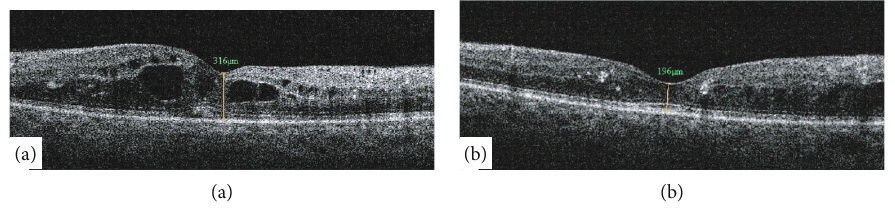
Figure 1: Optical coherence tomography (OCT) of the macula of a diabetic patient showing improvement of DME before (a) and after (b) anti-VEGF injections. There is marked improvement in the central foveal thickness as measured by OCT.